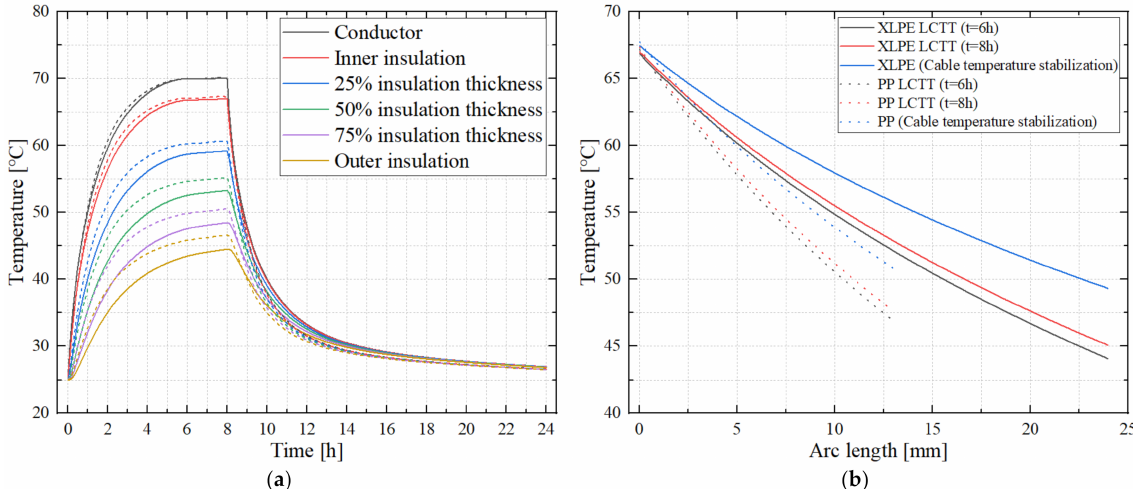
Figure 5. ( a ) Cable insulation temperature profile during LCTT (Line: XLPE, Dot: PP); ( b ) Cable insulation temperature profile (Line: XLPE, Dot: PP).